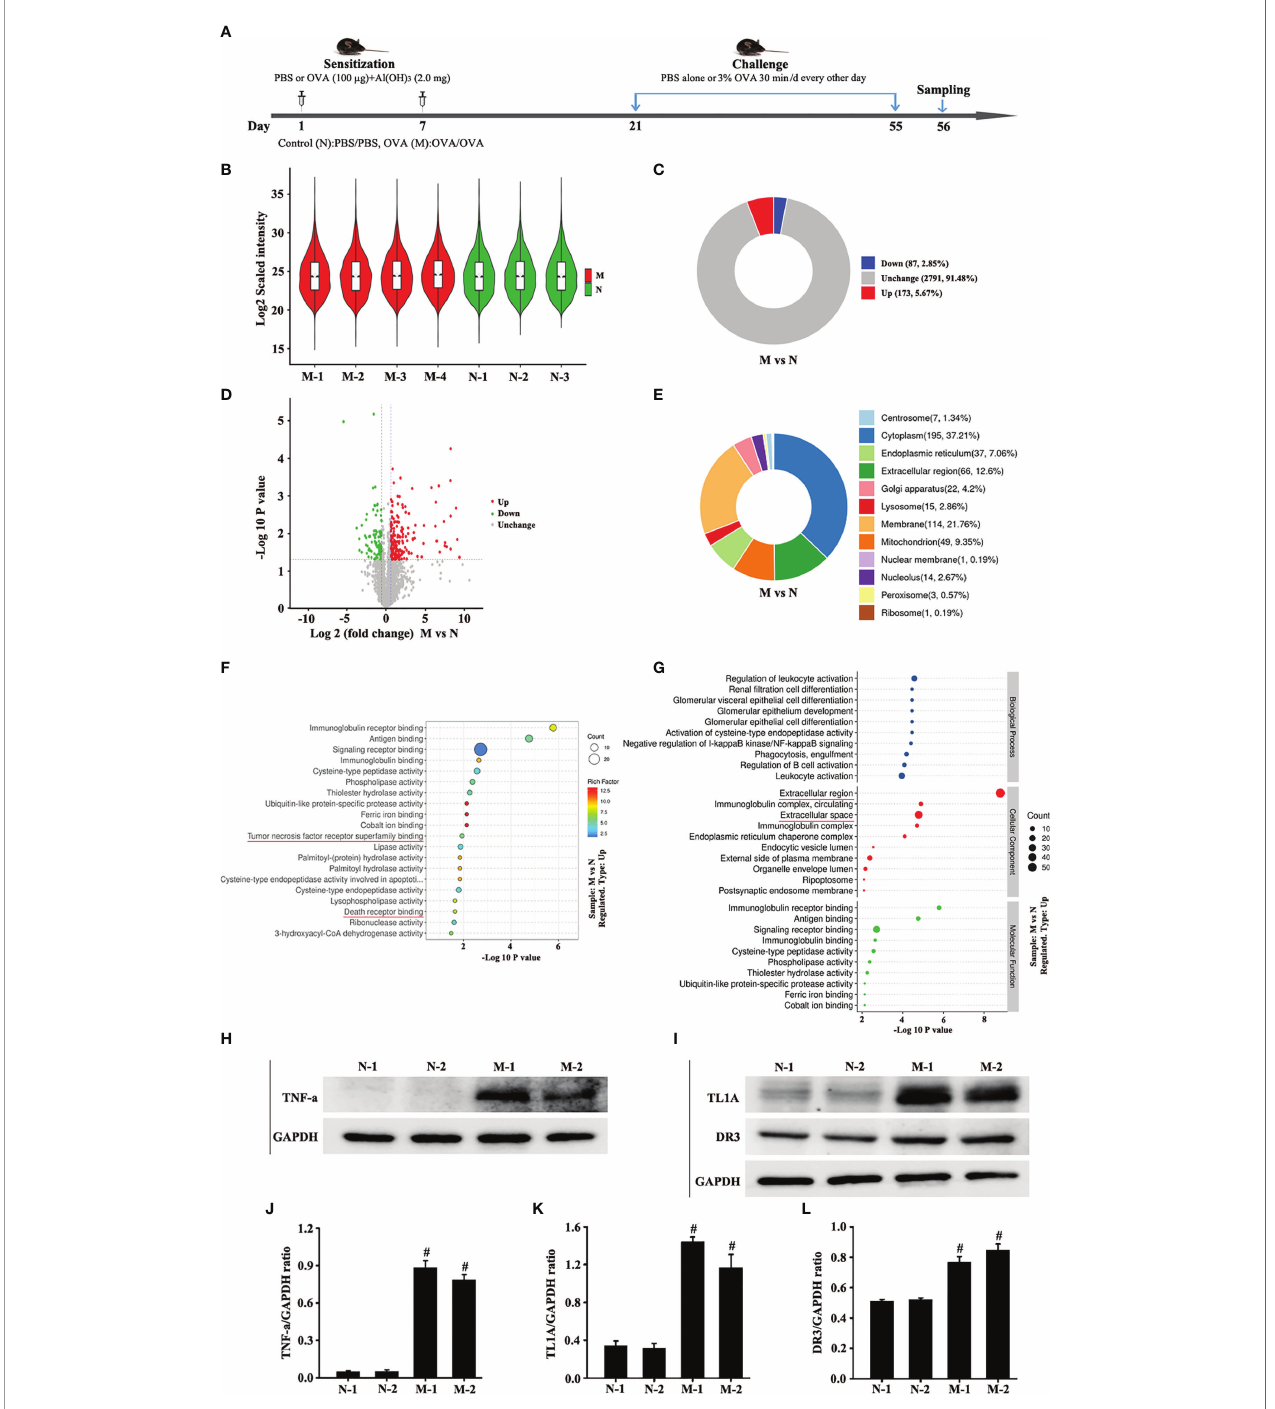
FIGURE 1 | Animal experimental schedule is shown in (A) ( n = 6 in each group). Analysis of differentially expressed proteins (DEPs) in OVA-induced asthma (M) compared with control (N). The boxplot shows the distribution of sample expression (B) . The pie chart shows the number and proportion of DEPs between groups (C) . The volcano plot exhibits the quantitative expression of DEPs between groups (D) . The pie chart displays the subcellular localization of DEPs between groups (E) . The chart shows the term of the top 20 signi fi cance of differential protein enrichment between groups (F) . The chart illustrates the biological process, cellular component, and molecular function (G) . Top 10 term of difference protein enrichment in the three branches (G) . Finally, we combined the differential protein dataset to detect the changes of TNF-a (H) and TL1A/DR3 (I) in the mouse lungs via Western blotting analysis. (J) intensity analysis of (H) . (K, L) intensity analysis of (I) . Data are expressed as the means ± SD for three independent experiments. # p < 0.05 versus the control